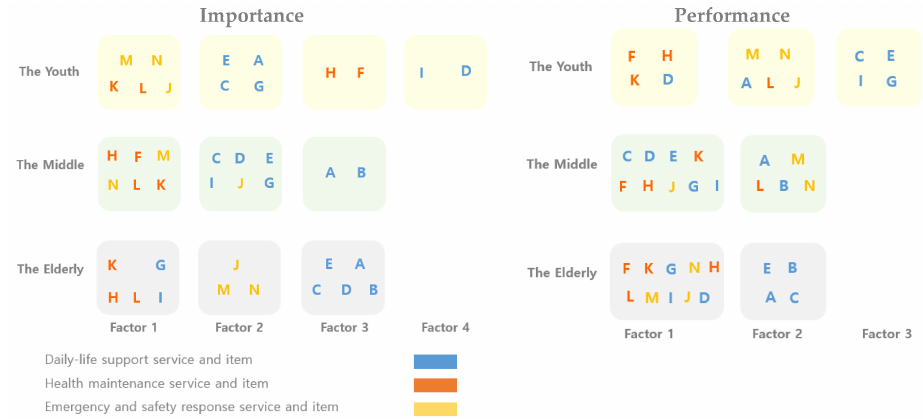
Figure 7. Age group-specific